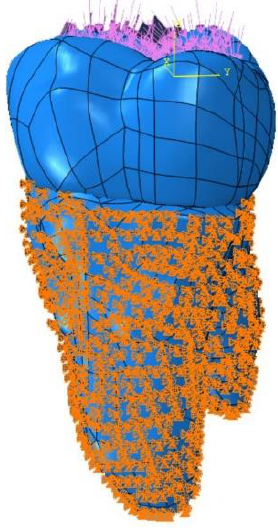
Figure 4. Load and boundary